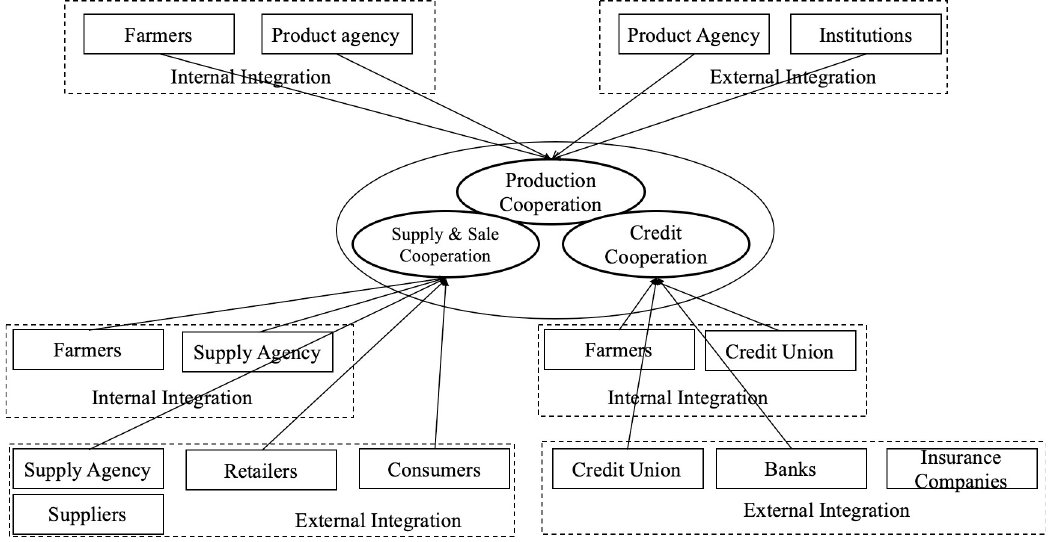
Fig 8. The Meiyu Cooperative’s trinity supply chain mode (based on internal and external supply chain integration theories).